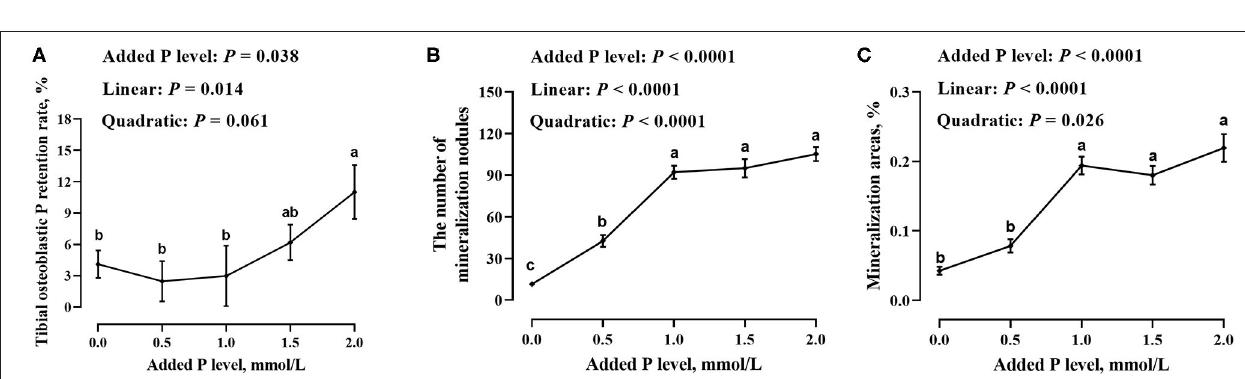
protein expression of MEPE increased quadratically ( p = 0.005)